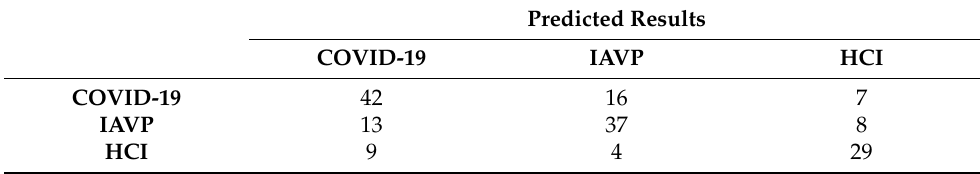
Table 3. Confusion matrix of COVID-19, IAVP, and a Healthy Candidate without infection (HCI).